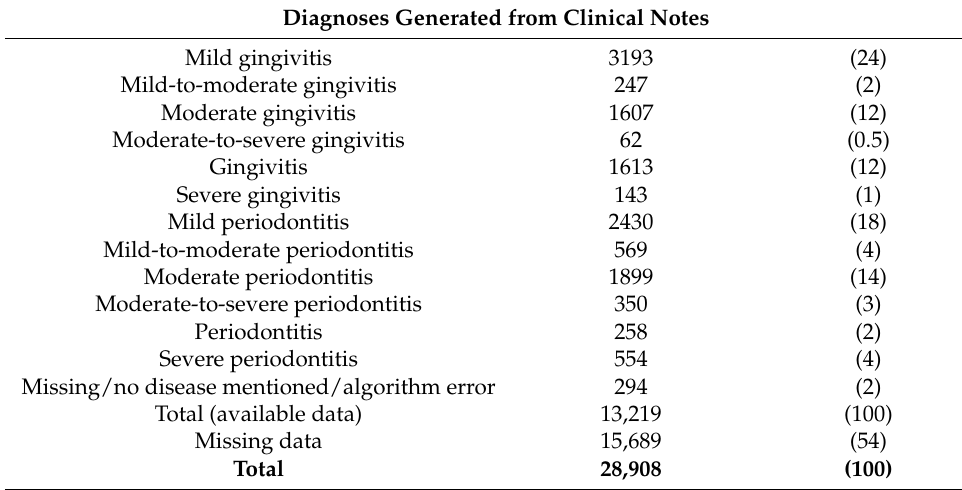
Table 3. Periodontal diagnoses generated from clinical notes.